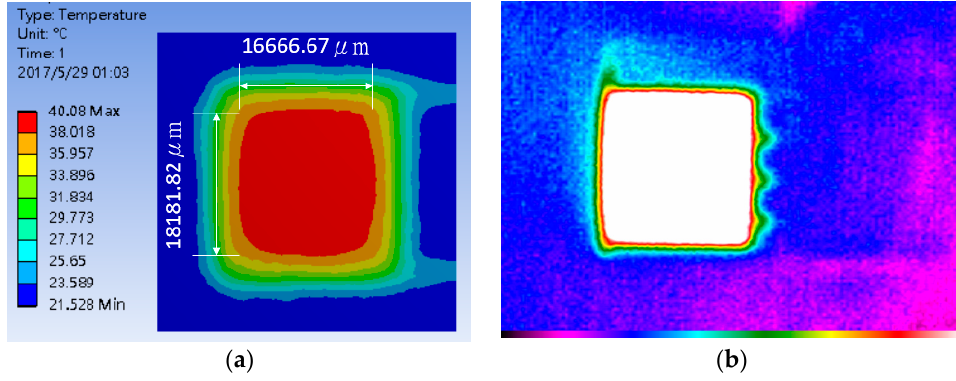
Figure 9. Thermal distribution of flexible polymer/multi-walled carbon nanotube sensor array: ( a ) Simulation result; ( b ) Thermographic measurement.